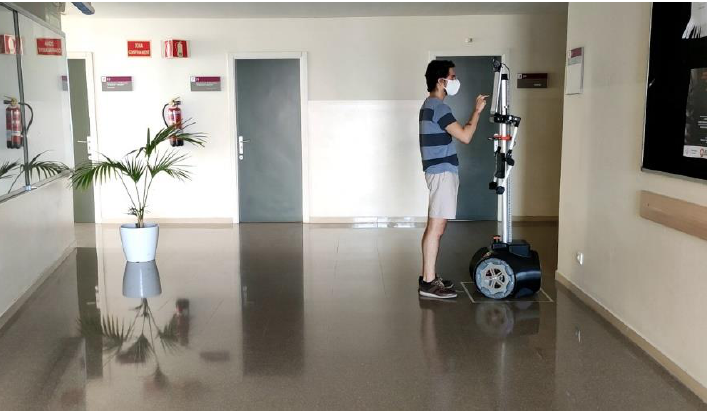
Figure 1. Image of one of the authors of the paper preparing the mobile robot APR-02 for an autonomous exploration under COVID-19 restrictions.